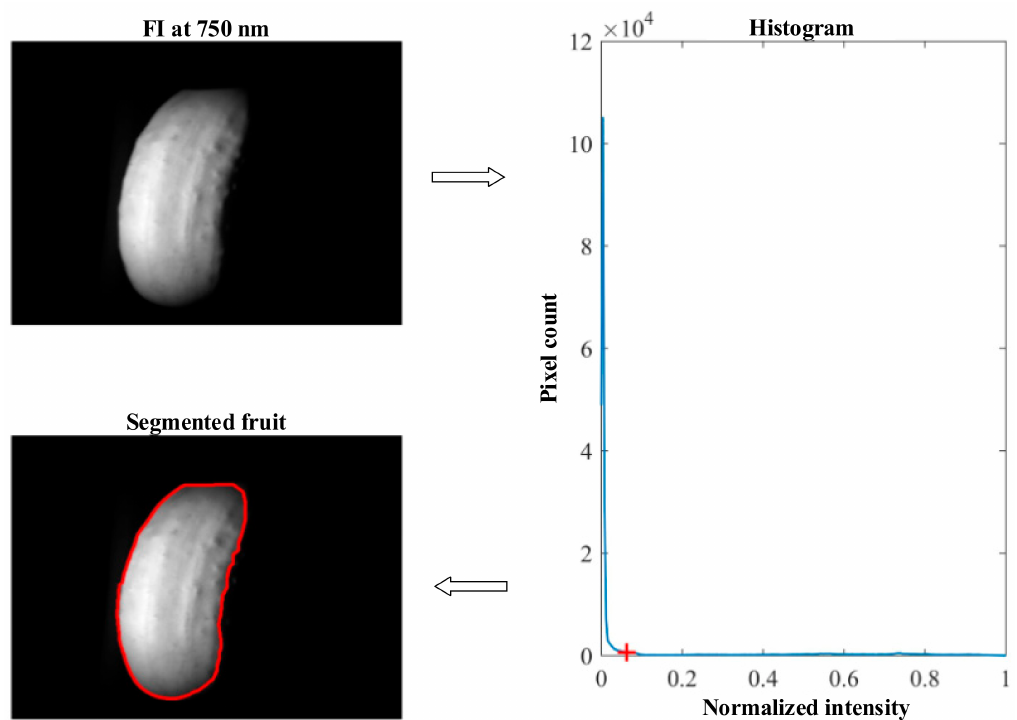
Figure 4. Fruit segmentation from the background by automatically thresholding the histogram of a fluorescence image (FI) at 750 nm. The red-cross marker in the histogram indicates the threshold determined by a unimodal thresholding technique [31], and the area enclosed by the red line is the resultant fruit